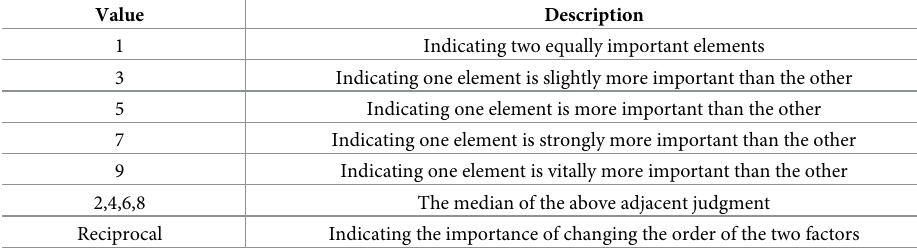
Table 1. The linguistic scale and corresponding triangular fuzzy